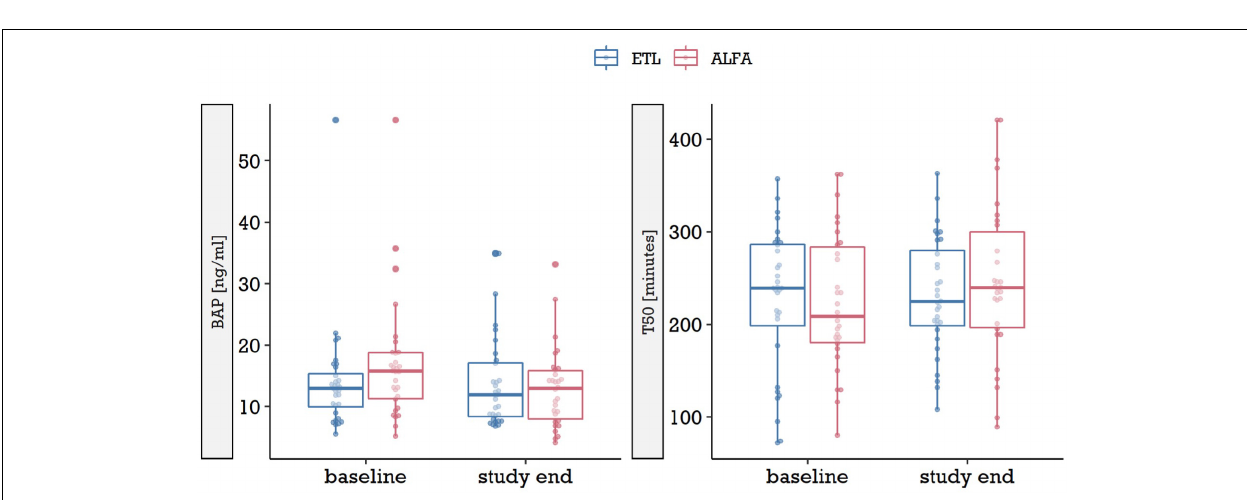
FIGURE 1 | Biomarker levels at baseline and over time in the two treatment arms, ETL and ALFA. The boxplots in 12-week-increments represent all data in the preceding 12 weeks, by treatment, on a log 2 scale. Trajectories are represented by non-parametric smoothing (loess curves). ETL, Etelcalcetide; ALFA, Alfacalcidol.